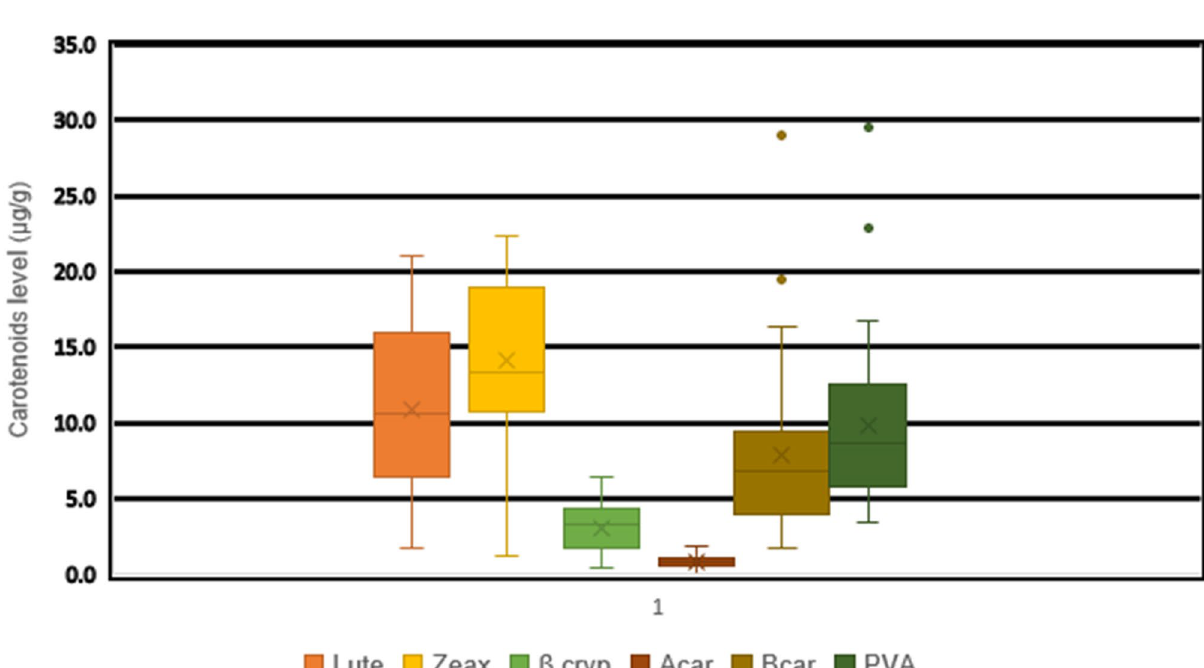
Figure 4. Distribution of the different carotenoids across the S4 inbred lines derived from